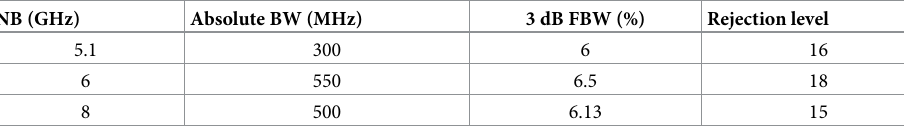
Table 3. Experimental outcomes of the proposed tri notch